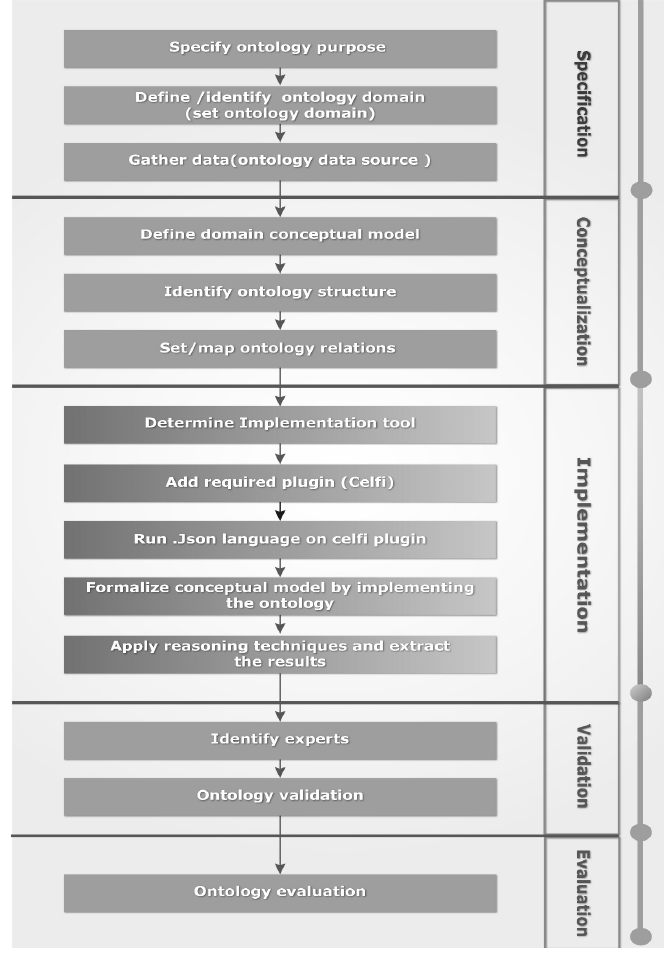
Figure 3. Semi-automatic methodology for ontology